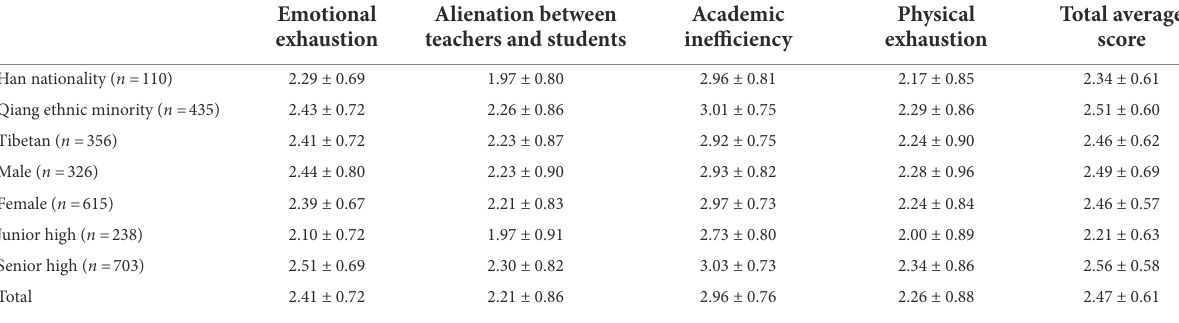
TABLE 2 Academic burnout among adolescents in Wenchuan area during the COVID-19 pandemic (M ± SD).